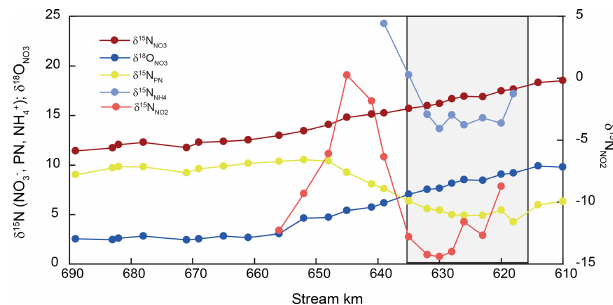
Figure 3. Isotopic changes in DIN and particulate nitrogen in SPM (PN) along the estuary. The harbor region is indicated by